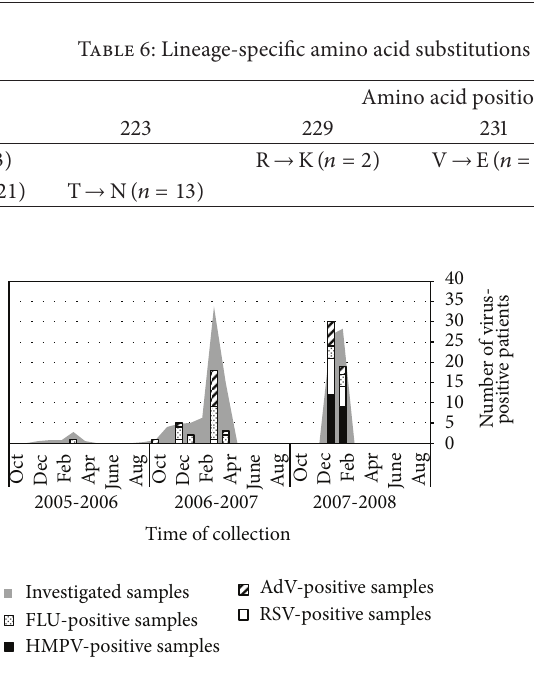
Figure 1: Monthly distribution of respiratory viruses causing LRTI. From 2005 to 2008, respiratory samples from patients with LRTI were collected and investigated for the presence of RSV, AdV, HMPV, and FLU. The gray shaded area in this figure shows the number of investigated samples per month. Each number of virus- positive samples is represented both with a bar and absolute values in the abscissa.